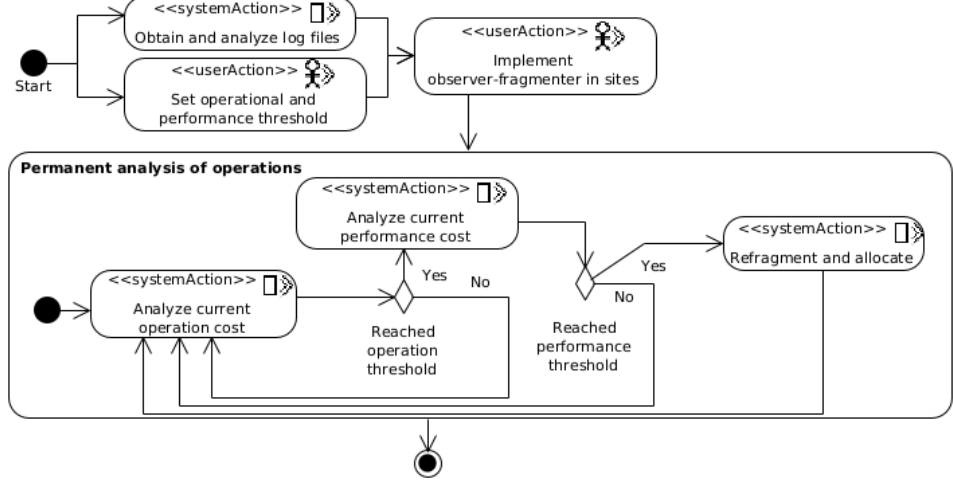
Figure 2. Dynamic fragmentation method workflow contemplating CBIR.